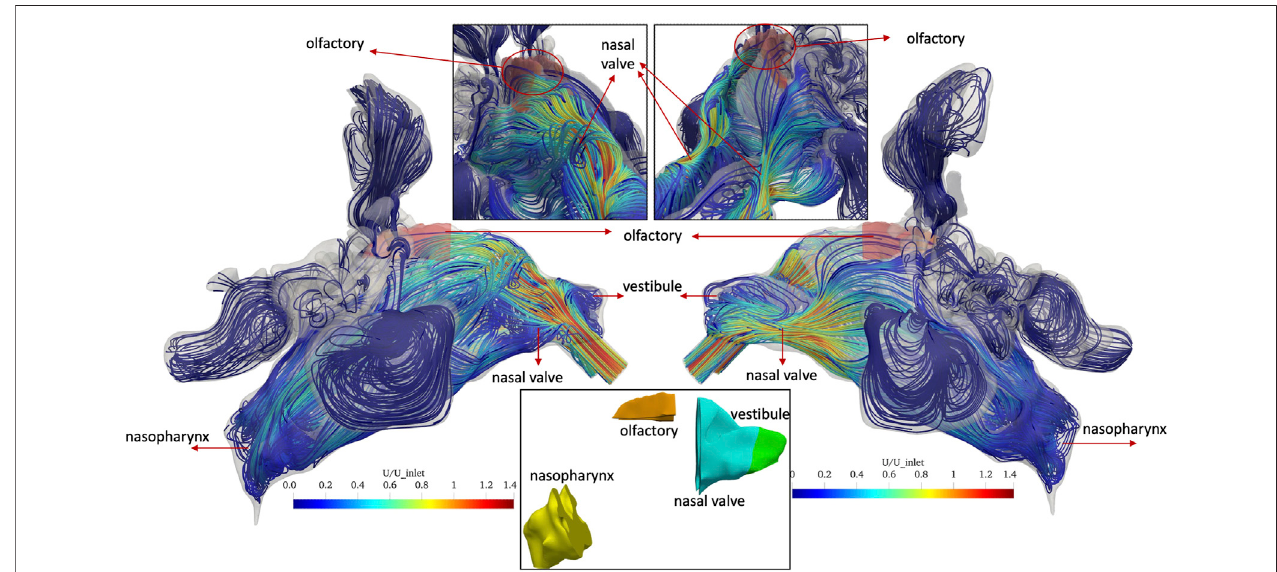
FIGURE 4 | Streamlines of the normal(-ized) air velocity U in the nasal cavity for non-pulsatile (constant) inlet fl ow of 4 L/min at the end of inhalation period ( t (cid:2) 1.98 s). Right (inlet) and left (exit) views and close-up views of the olfactory region (shaded in red) are given in the left and right panel, respectively. In the bottom panel, different regions of the nasal anatomy are